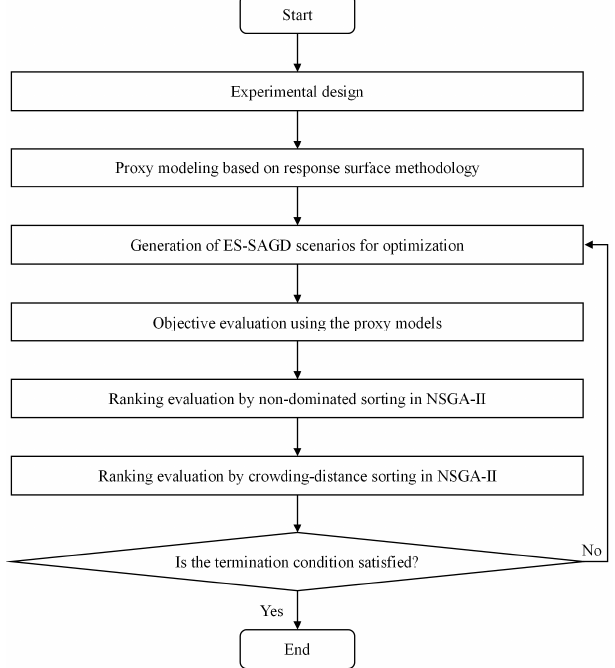
Figure 3. Flow chart to design the ES-SAGD process using hybrid NSGA-II algorithm combined with proxy models. The quadratic response surface models are developed from reservoir simulation results of training scenarios of ES-SAGD and then used to evaluate the quality of each ES-SAGD scenario regarding bitumen recovery, cumulative steam–oil ratio, and cumulative solvent–steam ratio. NSGA-II generationally evolves the ES-SAGD scenarios using non-dominated sorting and crowding-distance sorting until the stopping criteria are satisfied.